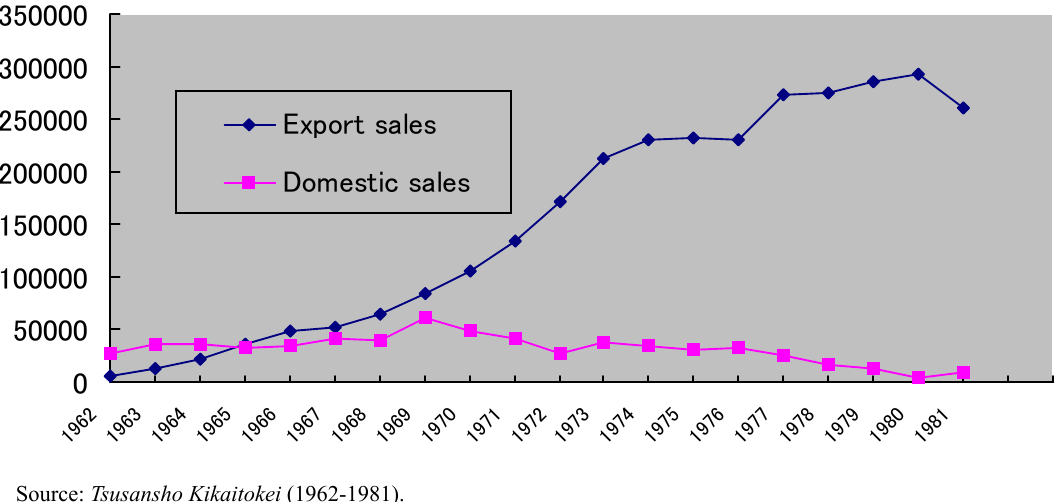
Figure 1. Number of Sales of Sporting Gun